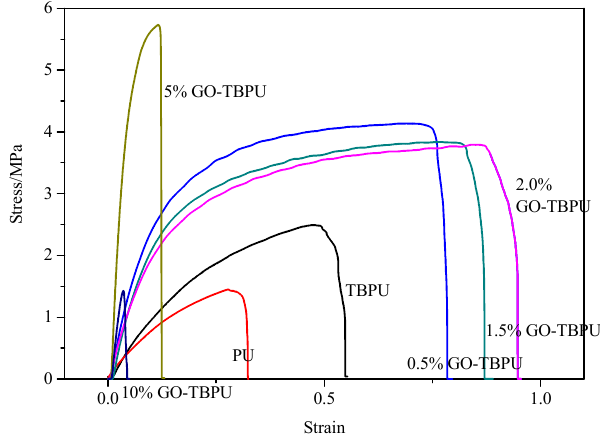
Figure 5. The stress-strain curves of PU, TBPU, and GO-TBPU membranes.